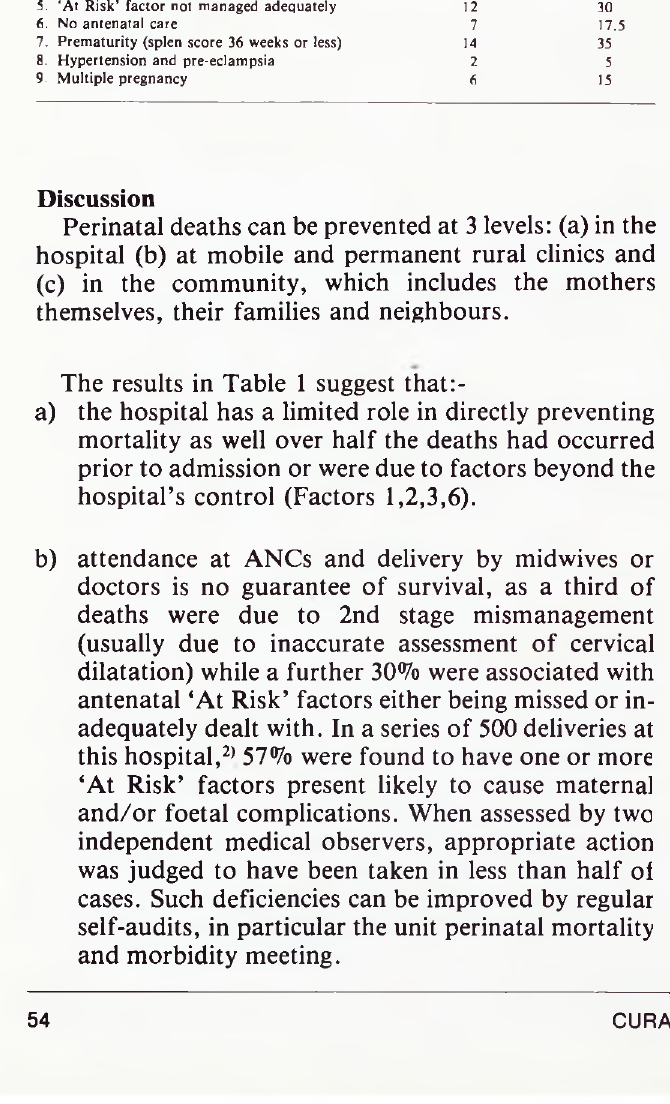
TABLE 1 AVOIDABLE PERINATAL